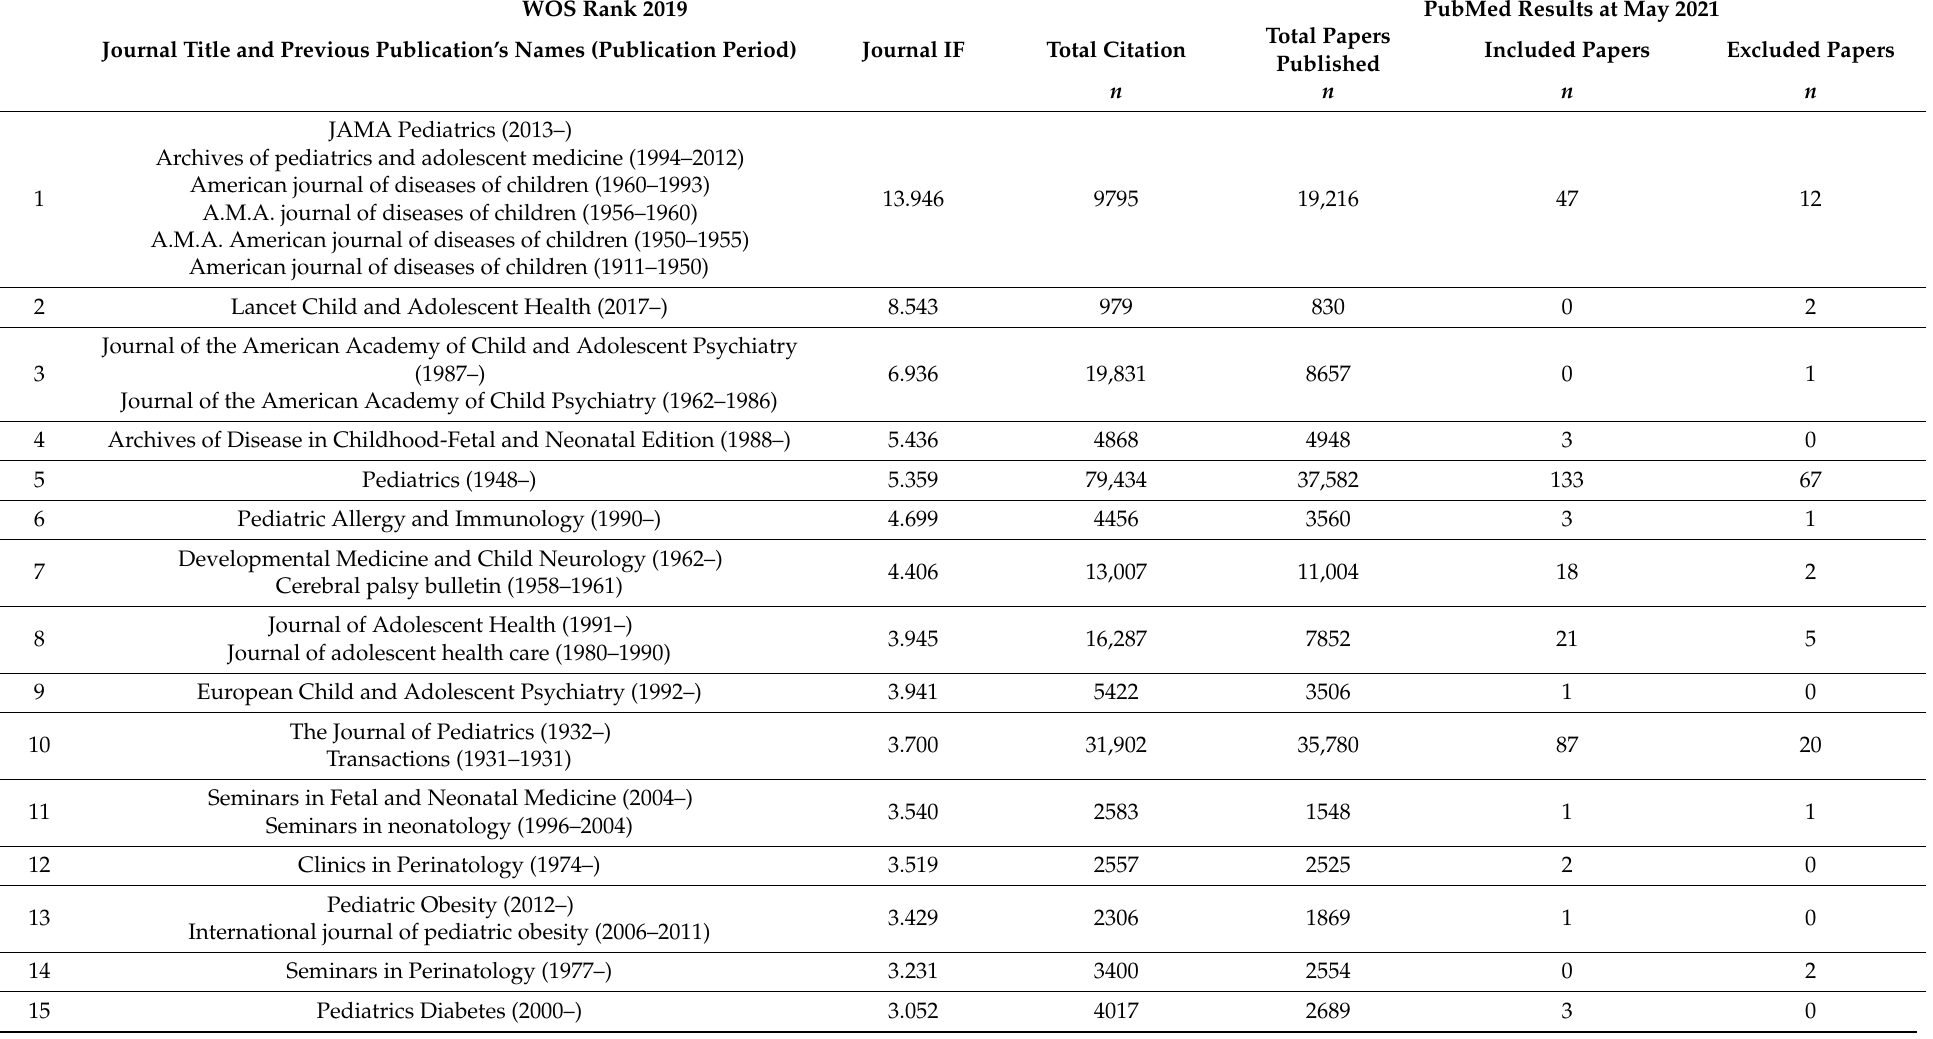
Table 1. Bibliometric characteristics of the included pediatric journals and PubMed research results at May